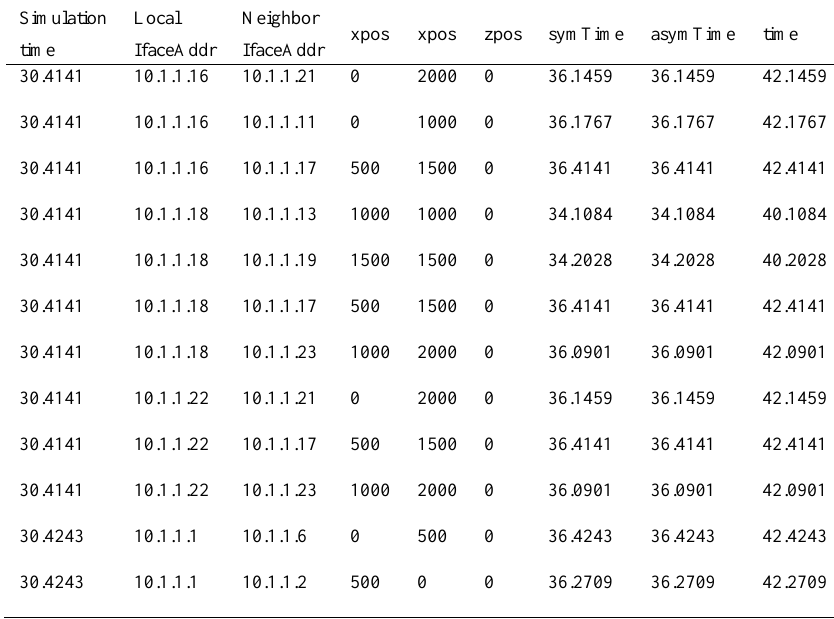
Table 3 The LinkSet when nodes remain